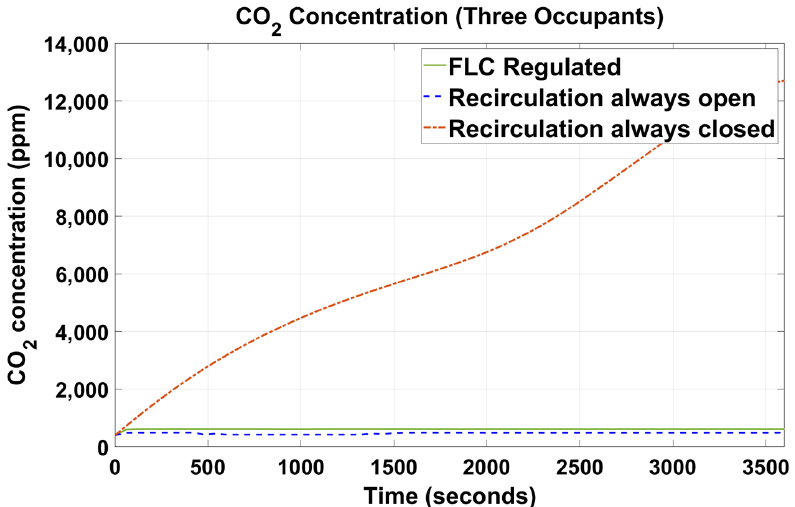
Figure 10. CO 2 concentration of the simulated vehicle cabin with three